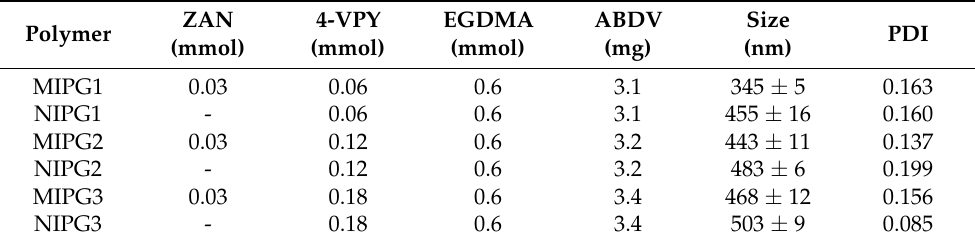
Table 1. Composition of ZAN imprinted polymers synthesized in 400 µ L anhydrous ACN and their corresponding